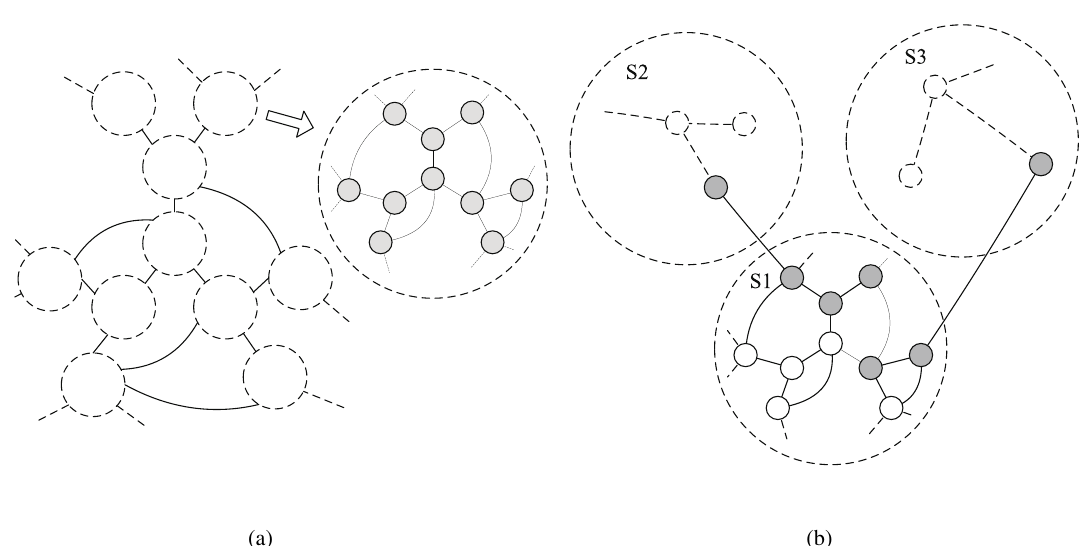
Fig.1. (a) The abstract of the community network based on the Cayley tree. Communities (denoted by dashed circles) with dense internal connections are linked together with external connections. Curves denote random links between two nodes (in the community) or two communities. (b) The virus attacking behaviors on the community network. The virus spreads from the infected nodes (the grey ones) to susceptible neighbors (the white ones) in the community and susceptible ones in other communities along external